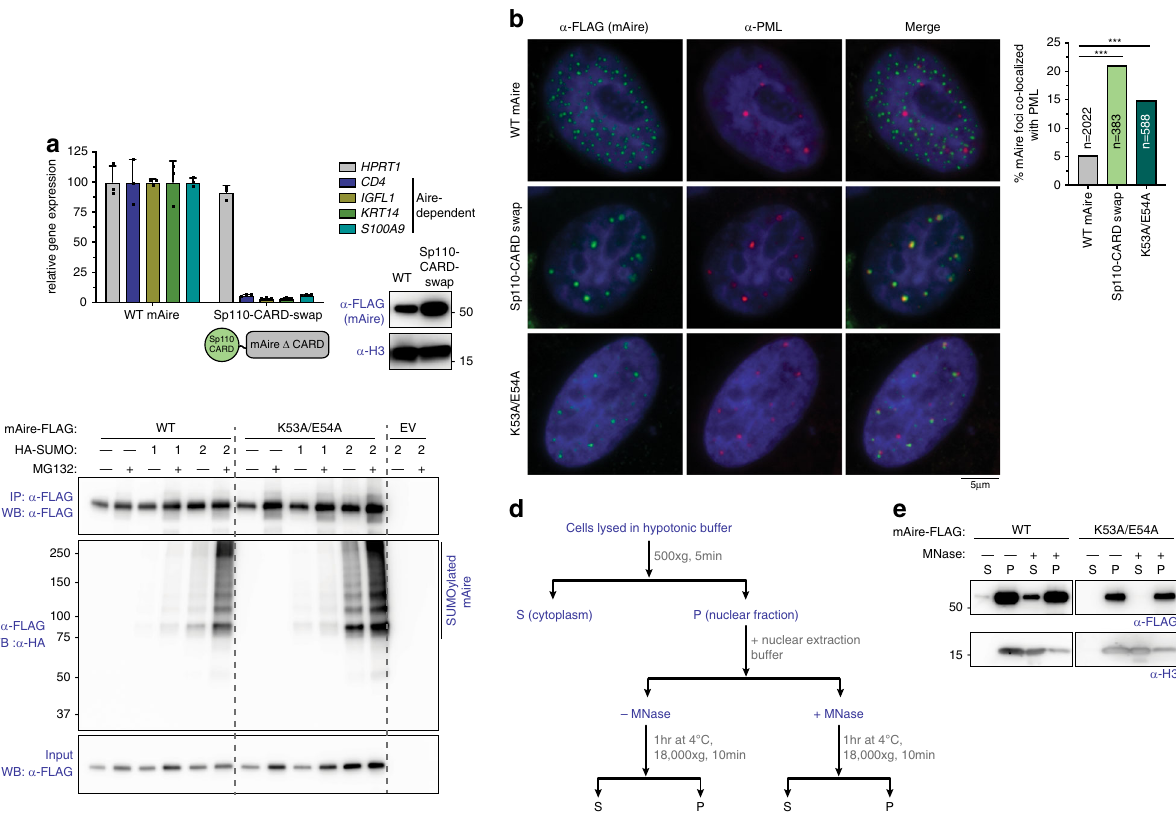
Fig. 3 Aire mutants with increased PML association are impaired in transcriptional activity and are hyper-SUMOylated. a Transcriptional activity of mAire and Sp110-CARD swap, where Aire CARD was swapped with Sp110 CARD. Experiments were performed as in Fig. 1g and presented as mean ± s.d., n = 3. Bottom right, WB of mAire and histone H3. b Representative fl uorescence microscopy images of FLAG-tagged WT, Sp110-CARD swap and K53A/ E54A mAire variants in 4D6 cells. Note that 4D6 cells were used as these cells show more distinct PML bodies and are fl atter than 293 T, allowing more robust analysis of Aire foci and their endogenous PML body localization. Cells were immunostained with anti-FLAG (mAire) and anti-PML. Right, quanti fi cation of the Aire foci colocalized with endogenous PML bodies from automated image analysis (see Supplementary Fig. 3a, b for the de fi nition of colocalization). n = number of Aire foci examined per sample. Statistical signi fi cance comparisons were calculated using a two-tailed Student ’ s t -test for two population proportions where each population consists of all individual Aire foci examined. *** p = 5.57e-26 and 6.46e-15 for Sp110-CARD swap and K53A/E54A, respectively. See also Supplementary Fig. 3c for FLAG-tagged hAire stably expressed in 4D6 cells. c SUMO modi fi cation analysis of WT mAire and K53A/E54A. FLAG-tagged mAire was co-expressed with HA-SUMO1 or -SUMO2 in 293 T cells. Cells were treated with MG132 (10 μ M) for 24 h before harvesting. mAire proteins were immunoprecipitated (IPed) using anti-FLAG beads under semi-denaturing condition and analyzed by anti-HA WB. d Schematic of chromatin fractionation analysis of Aire. 293 T cells were transfected with mAire expressing plasmids for 48 h before harvesting. Solubility of Aire and chromatin (as measured by Histone H3) before and after MNase treatment was analyzed by WB. e Chromatin fractionation analysis of mAire WT and K53A/E54A. Experiments were performed as in ( d